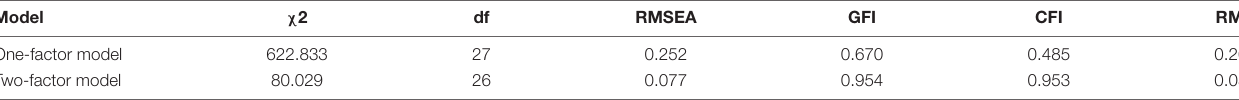
TABLE 3 | Results of confirmatory factor analysis ( N = 349).